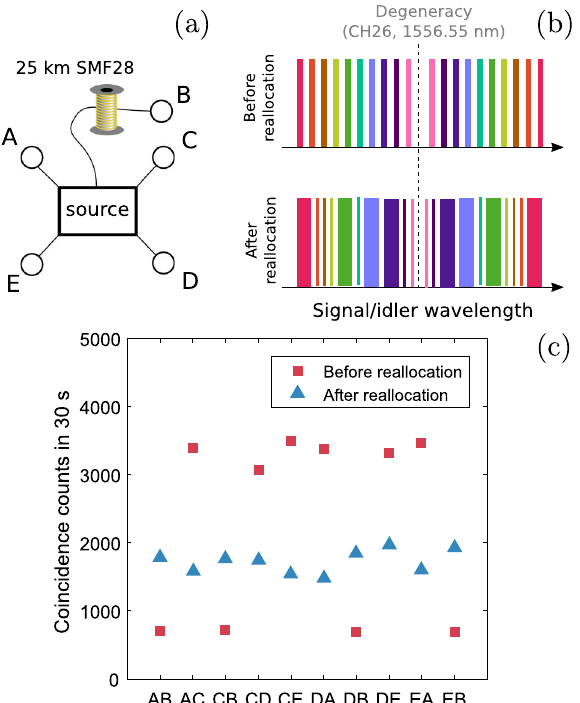
Fig. 6 Flexible bandwidth allocation in an unbalanced network. a Sketch of the experiment. In a fully connected network with N = 5 users, user B is separated from the source by a 25 km long SMF28 fi ber spool. b Schematic of the bandwidth distribution between all two-user links before and after applying the bandwidth reallocation algorithm. After reallocation, the four links (red, dark green, light blue, and dark blue) that connect user B to the rest of the network are allowed a broader bandwidth. c Coincidence counts for each two-user link before (squares) and after (triangles) bandwidth